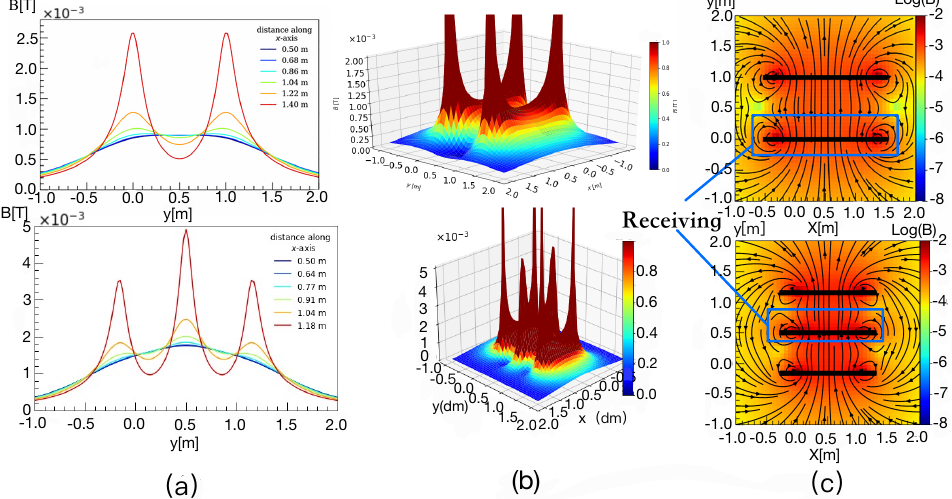
Figure 3. Comparison of the described structure with the conventional WPT magnetic field. ( a ) Numerical plot of the magnetic field. ( b ) Magnetic field distribution diagram. ( c ) Magnetic field cross section